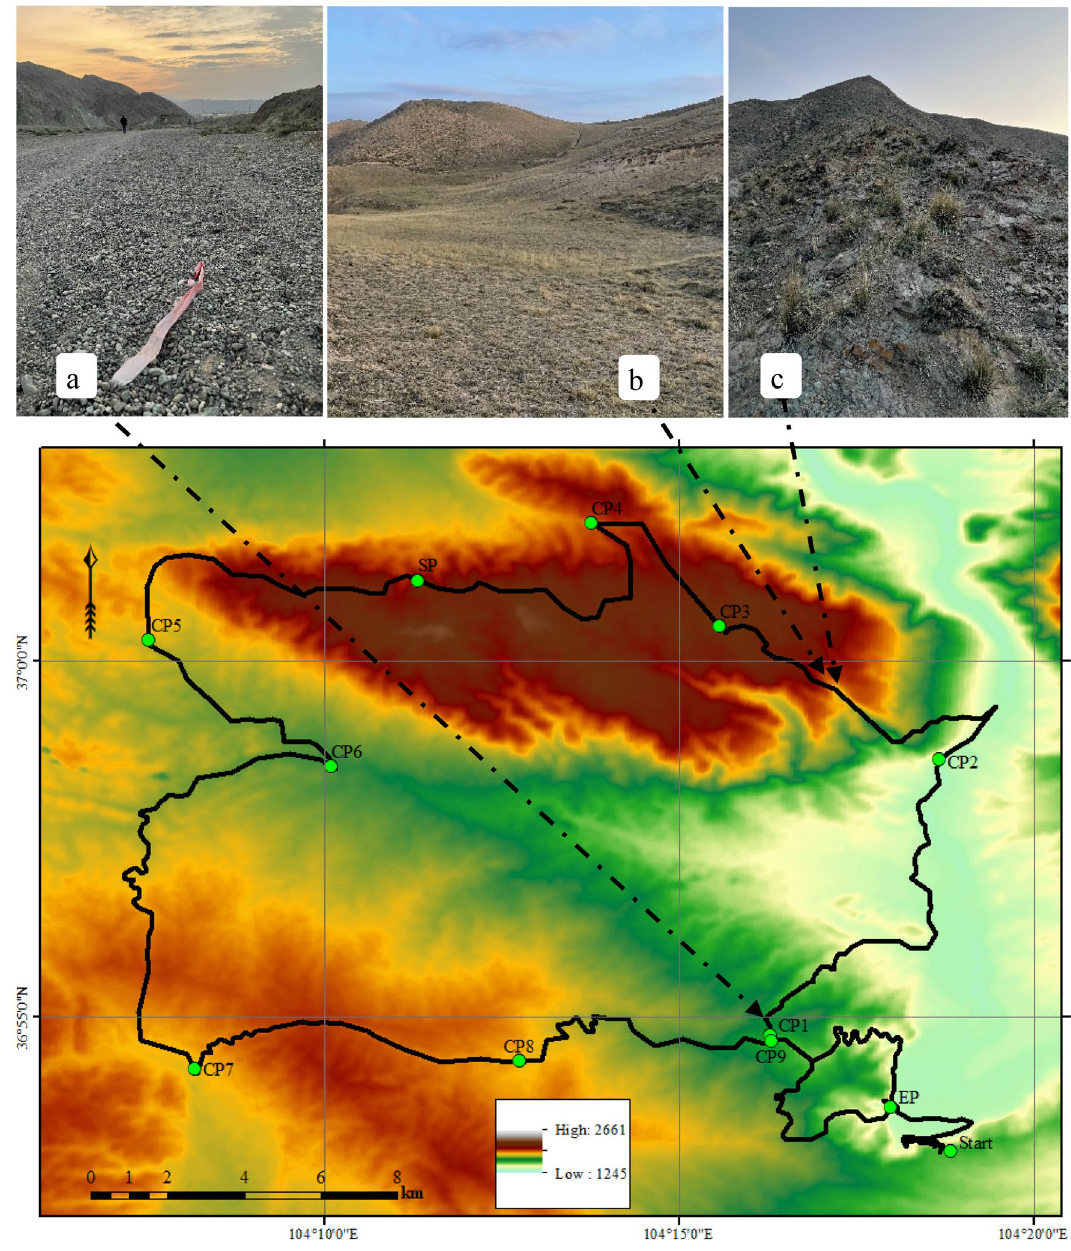
Figure 3. Marathon route and start, check, supply and endpoint and pictures along the route. ( a ) Photo of the race route on CP1. ( b,c ) photos of the race route on CP2–CP3. ‘Start’ is the starting point, CP1–CP9 is the checkpoint, SP is the supply point, and EP is the